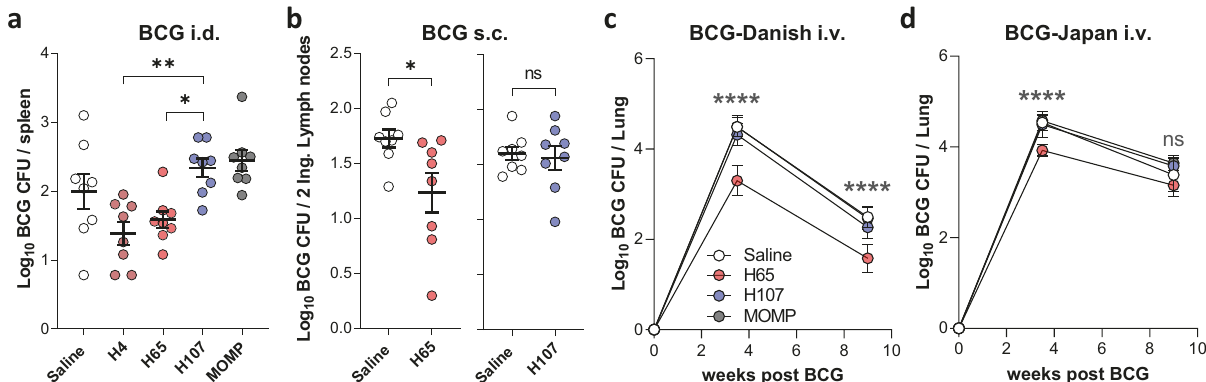
Fig. 2 H107 does not induce cross-reactive immunity to BCG. a CB6F1 mice were immunized with H4/CAF ® 01, H107/CAF ® 01, H65/CAF ® 01, or MOMP/ CAF ® 01 and inoculated intradermally (i.d.) with BCG and CFUs were determined in the spleens of vaccinated animals 3.5 weeks later ( n = 8, H4 vs. H107 p = 0.0034; H65 vs. H107 p = 0.0298). b CB6F1 mice were immunized with H65/CAF ® 01 or H107/CAF ® 01 and inoculated with BCG subcutaneously (s.c.) at the tail-base. BCG CFUs were determined in the inguinal lymph nodes 6 weeks after inoculation ( n = 8, two-sided unpaired t test, * p = 0.0257). c , d CB6F1 mice were immunized with saline (white), H65/CAF ® 01 (red), H107/CAF ® 01 (blue), or MOMP/CAF ® 01 (gray) and injected intravenously (i.v.) with BCG-Danish ( c ) or BCG-Japan ( d ) 6 weeks after the last immunization. BCG CFUs were enumerated in lungs 3.5 and 9 weeks post-BCG challenge ( n = 8) and p-values shown for Saline vs. H65. All data shown as mean ± SEM. ( a , c , d ) One-way ANOVA with Tukey ’ s Multiple Comparison test. p values; p values; * p < 0.05, ** p < 0.01, **** p < 0.0001, and ns (nonsigni fi signi fi cant difference was observed 9 weeks after infection in this (Fig. 3e) and I-A d :TB10.4 73-88 tetramer-staining analyses (Fig. 3f). experiment (Fig. 2d and Fig. S2a). In contrast, H107 immuniza- This reciprocal adjuvant effect was dependent on the combined presence of both the CAF ® 01 adjuvant and the protein antigen as neither co-administration of BCG with un-adjuvanted H107 protein (Fig. S3d) nor BCG with CAF ® 01 adjuvant alone sig- ni fi cantly increased TB10.4-speci fi c responses (Fig. 3g). To study the effect of subunit co-administration on the protective ef fi cacy of BCG in isolation, we co-administered BCG with the unrelated chlamydia-derived protein MOMP formulated with CAF ® 01. Similar to H107, co-administration of BCG + MOMP sig- ni fi cantly increased TB10.4 immune responses (Fig. 3g), and provided increased short (3.5wk) and long-term (16wk) protec- tion against aerosol Mtb challenge, compared to BCG alone (Fig. 3h & Fig. S3e). Similar to the TB10.4 immune responses, the protection was trending highest when BCG was co-administered with MOMP/CAF ® 01 (Fig. 3h, left), suggesting that the combi- nation of both the antigen and adjuvant is optimal for maximum synergy with BCG.